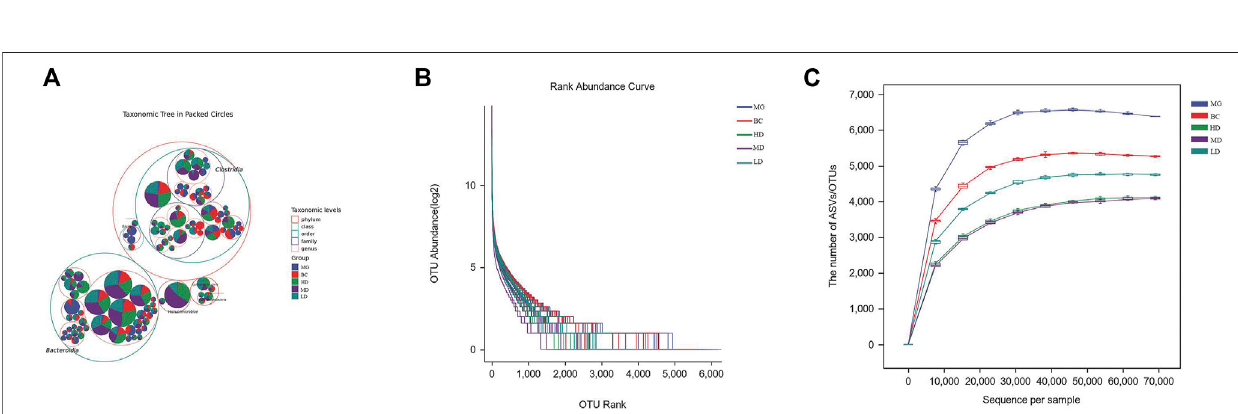
Frontiers in Pharmacology |